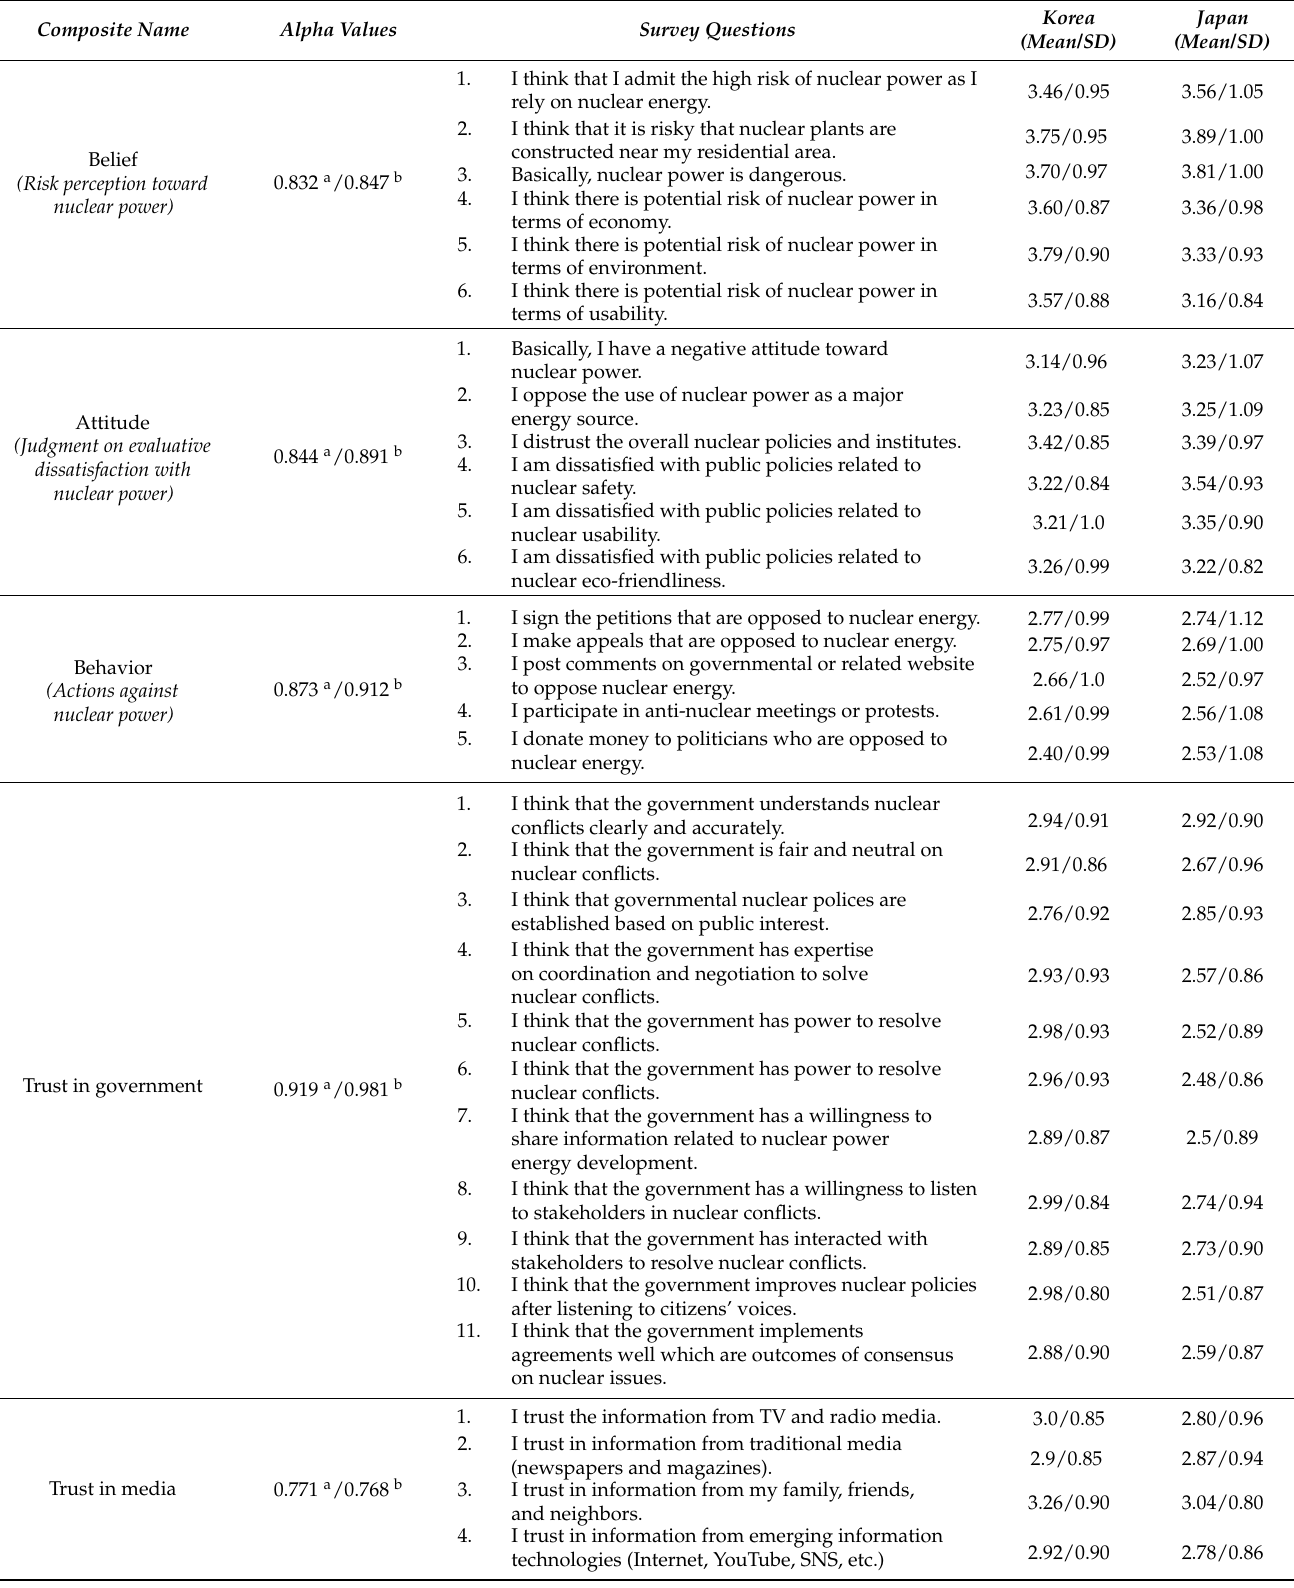
Table 2. Measures of